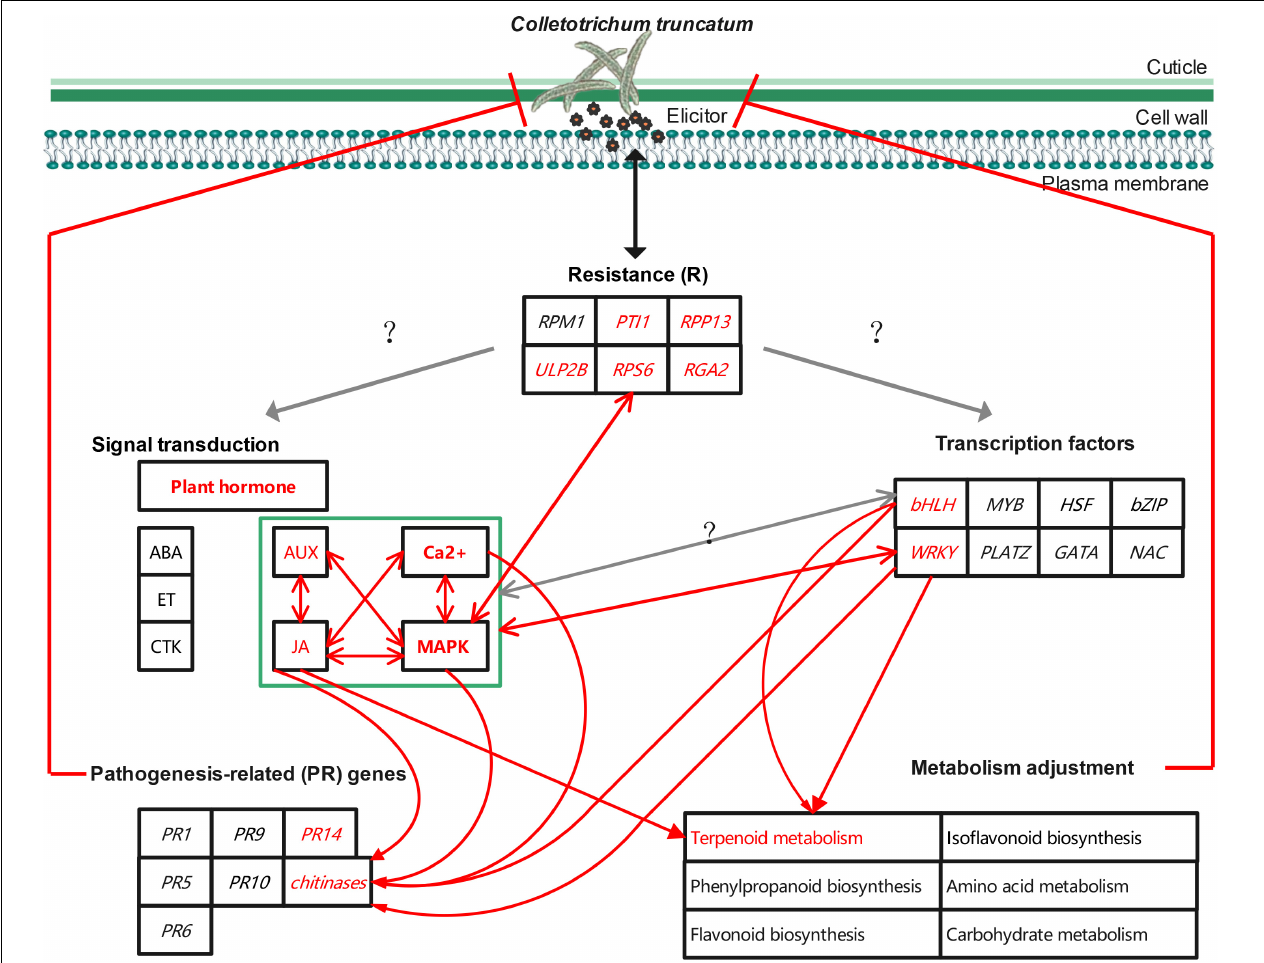
FIGURE 13 | Schematic diagram of the potential mechanism to improve soybean resistance to